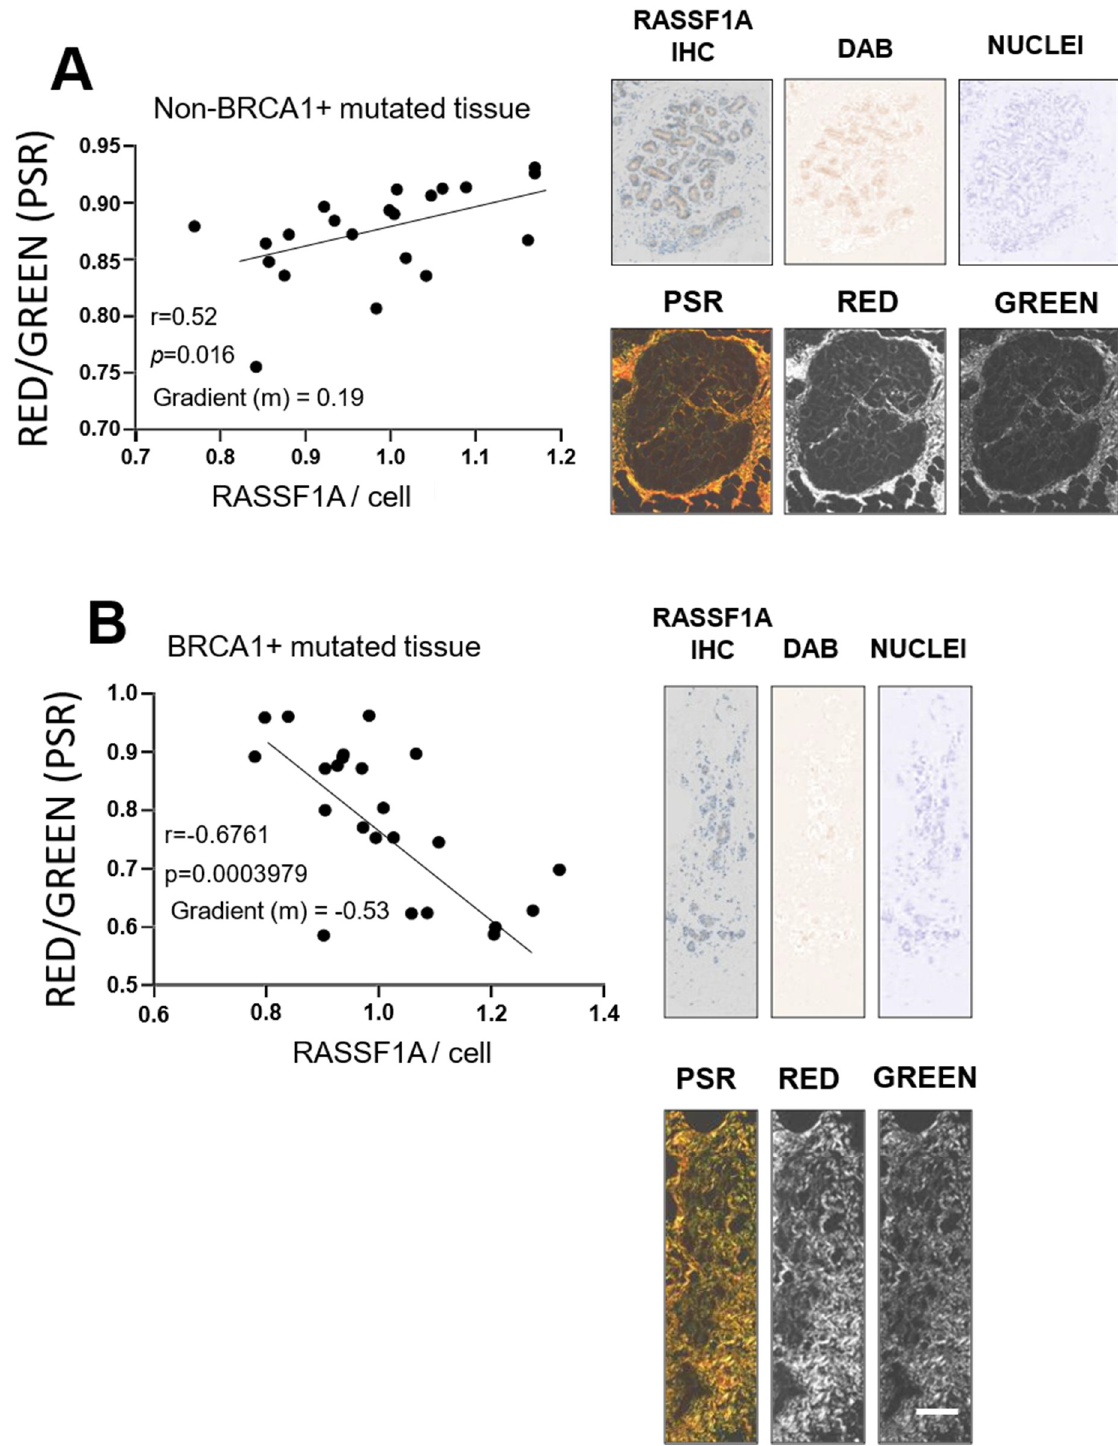
Figure 4. Local stiffness measures, as determined by relative Collagen I vs. III ratio (red vs. green in picrosirius red [PSR] stained tissues viewed under polarized light) versus per-cell RASSF1A expression in stroma adjacent to glandular epithelium non-mutant ( A ) and BRCA1 mutant ( B ) non-malignant human breast tissue. ( A ) A positive correlation was observed for RASSF1A cellular positivity and abundance of thicker collagen fibril bunding associated with Collagen I. ( B ) A negative correlation was observed in patients harboring BRCA1 gene mutations. Scale bar = 200 µ m. 3 images each from at least n = 5 patients were examined in A and B. Representative images from patients are shown on right with further images shown in Supplementary Figure S5.